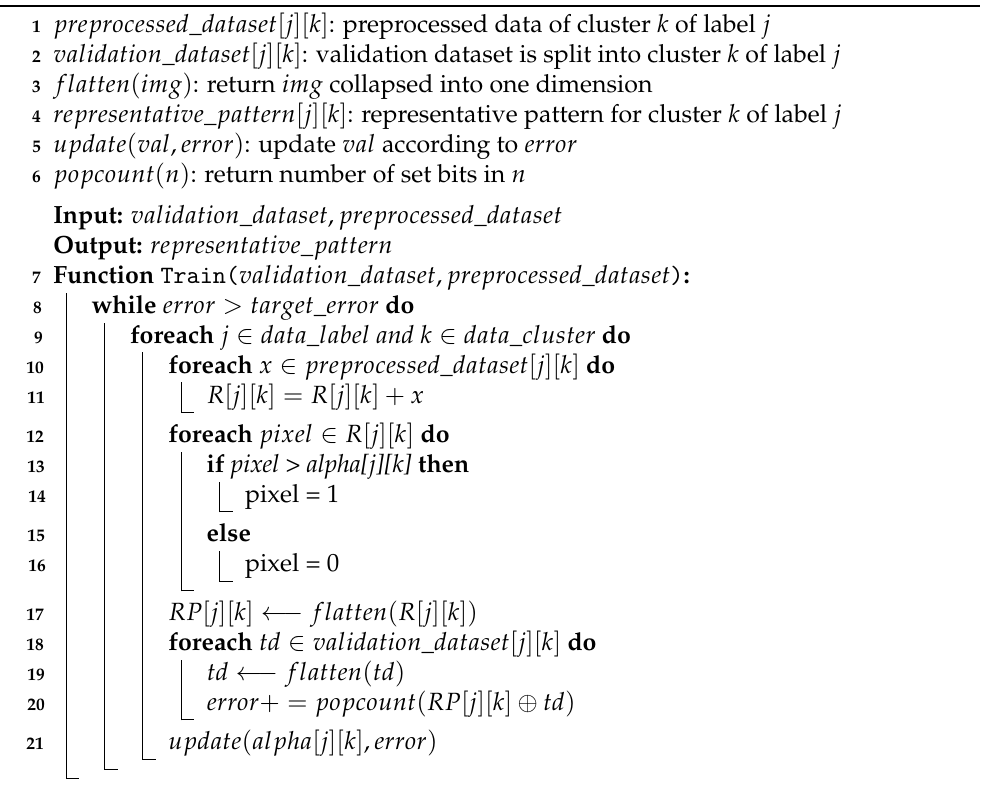
Figure 9. Overall algorithm of the training process. Algorithm 2: Pseudo code of training